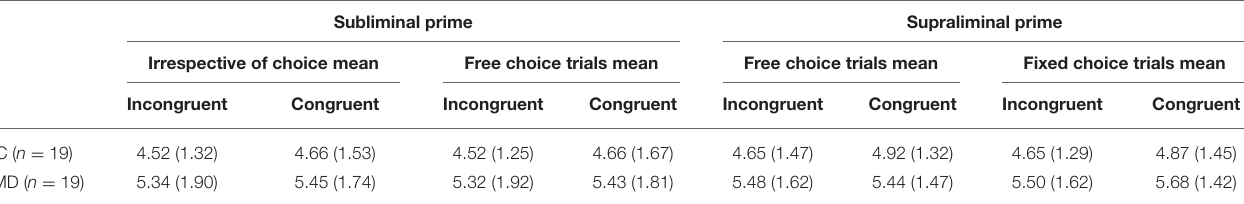
TABLE 3 | Agency rating group averages (SD) for different prime and choice conditions.